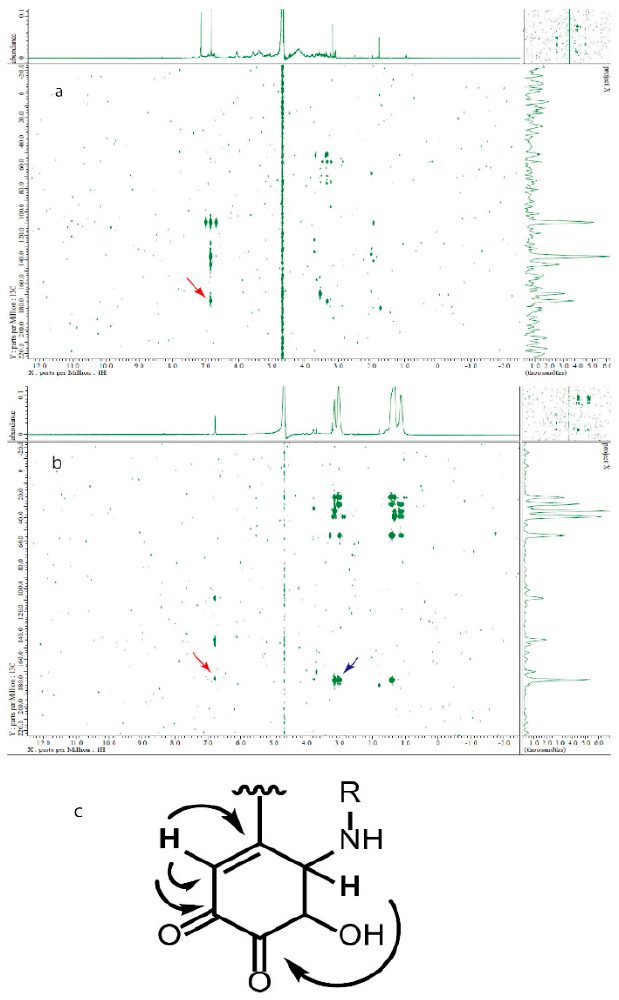
Figure 4. HMBC spectrum of tannic acid ( a ) and EPL-tannic acid ( b ). ( c ) shows a summary of HMBC spectra of EPL–tannic